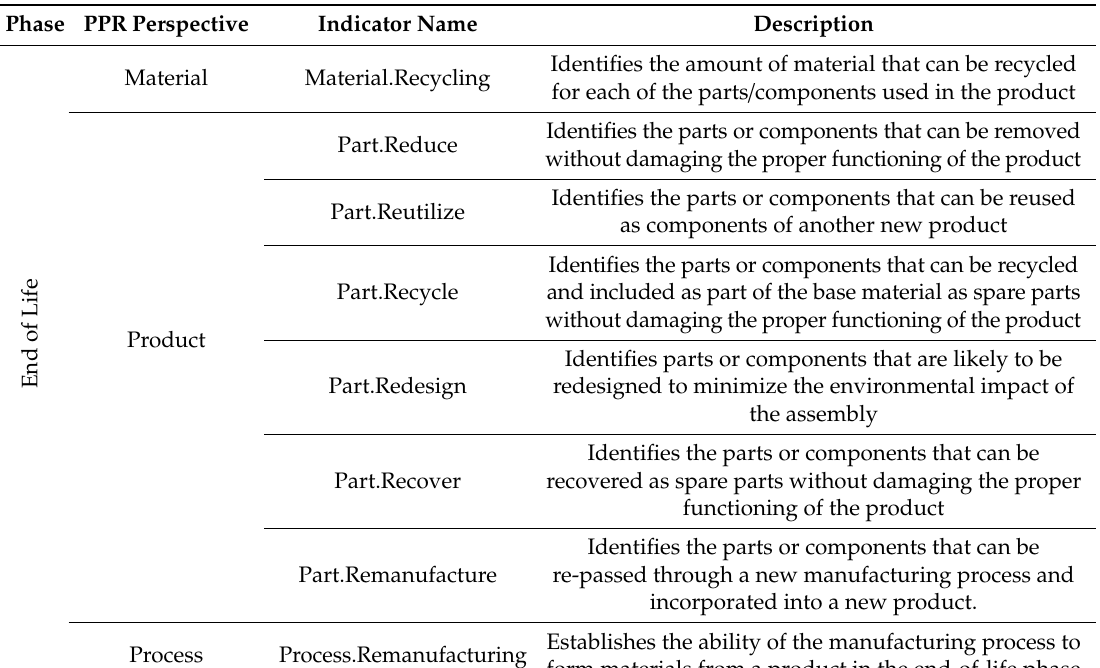
Table 7. End-of-life phase indicators definition.